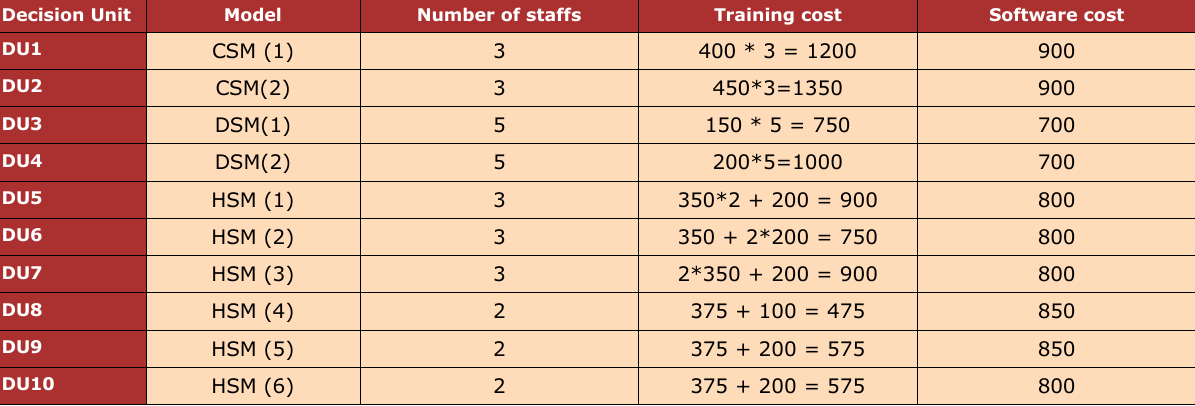
Table 10. DEA inputs for the setting with medium